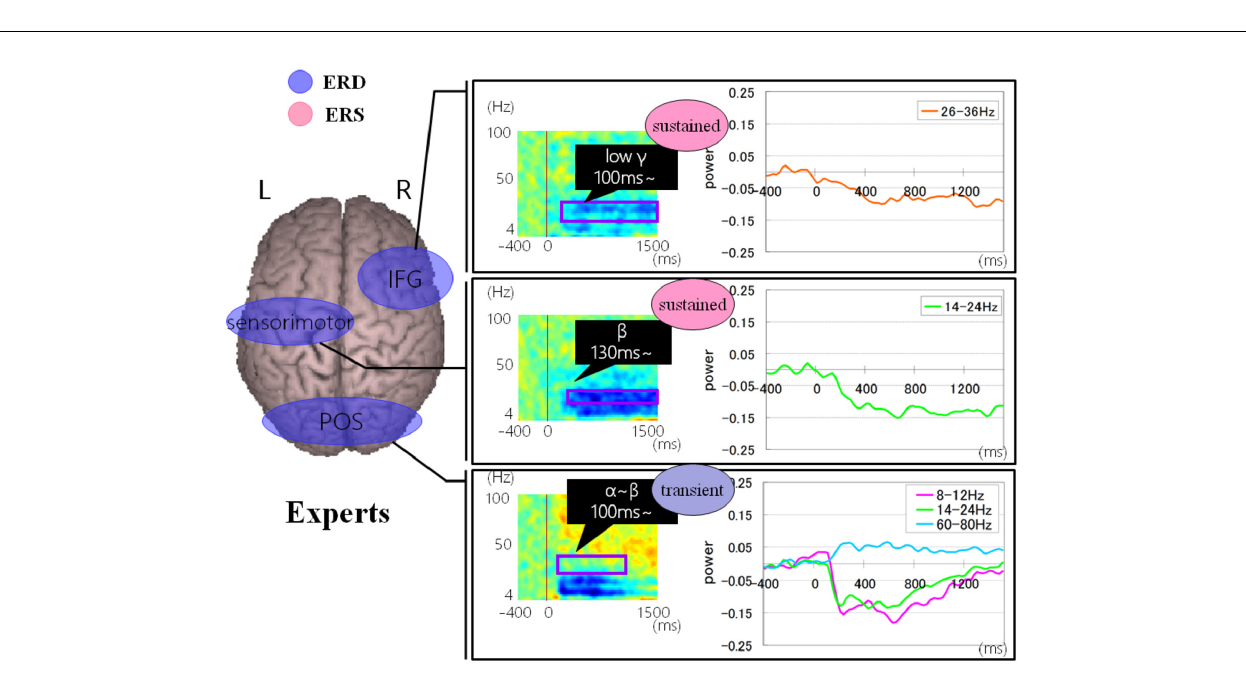
Frontiers in Human Neuroscience | www.frontiersin.org